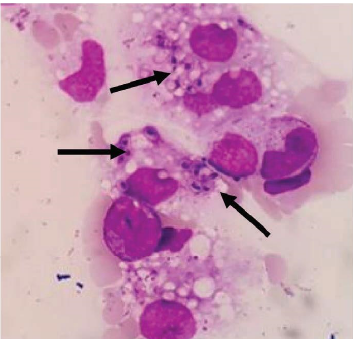
Figure 1: Initial bone marrow aspiration showing myelodysplasia syndrome (MDS) with refractory cytopenia with multilineage dysplasia (RCMD) subtype and infection with H. capsulatum inside the macrophages (taken 2weeks after admission and as the initial point to start antifungal treatment).